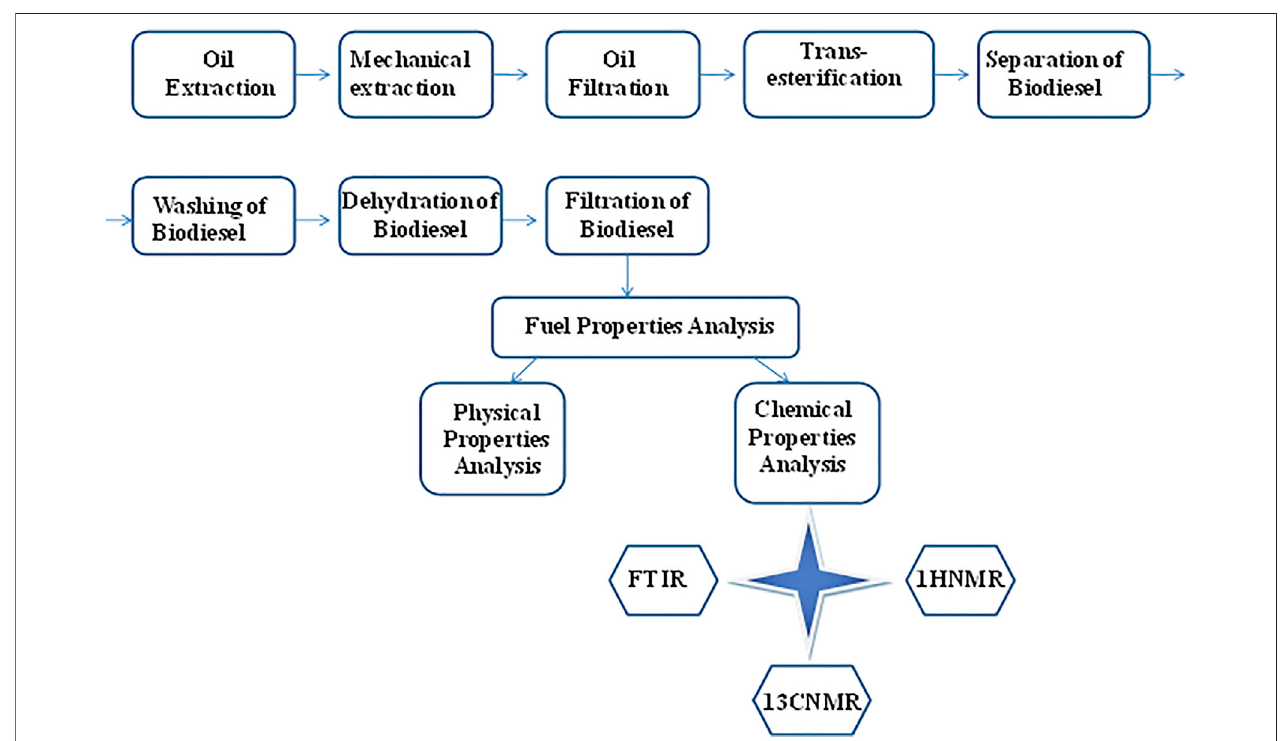
FIGURE 3 | Flow chart of the biodiesel synthesis techniques adopted for experimental work.